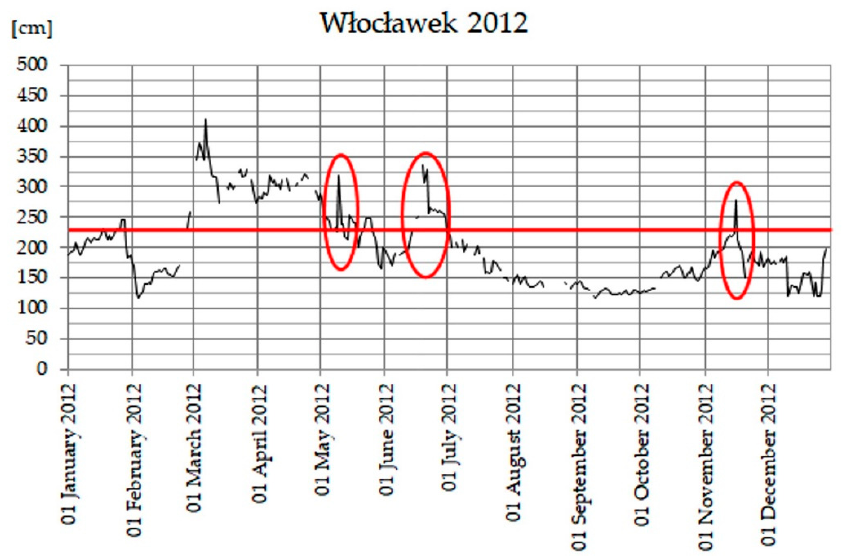
Figure 4. Water levels at the Włocławek water gauge. Red ellipses—emergency discharge, red line—flooding of the channel bars.